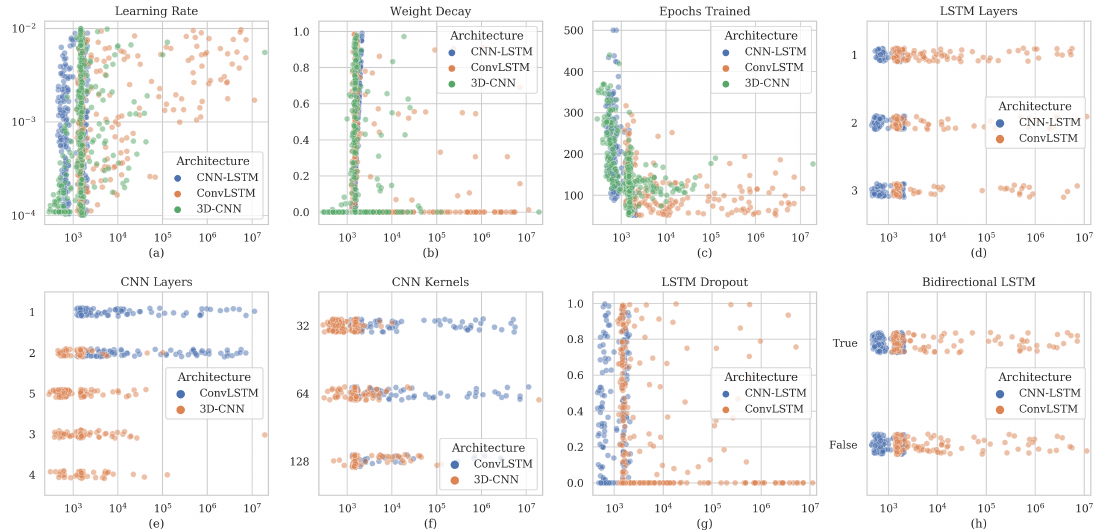
Figure 6. The architecture-specific distributions of hyperparameters against the test RMSE ( x axis). ( a , b ) are the optimizer hypeparameters and ( c ) is the training length in epochs. ( d , g , h ) are the LSTM architectural hyperparameters, while ( e , f ) are the CNN architectural hyperparameters. ( d , e , f , h ) contain categorical values in y axis with values spread category-wise for easier observation of clustering. The rest of the sub-figures have a continuous y axis. Table 6. The architecture specific hyperparameter values for the best performing models. The value types conform to the values given in Table 3. The feature extracting CNN of the CNN-LSTM was not tuned for hyperparameters as tuning results from previous study were